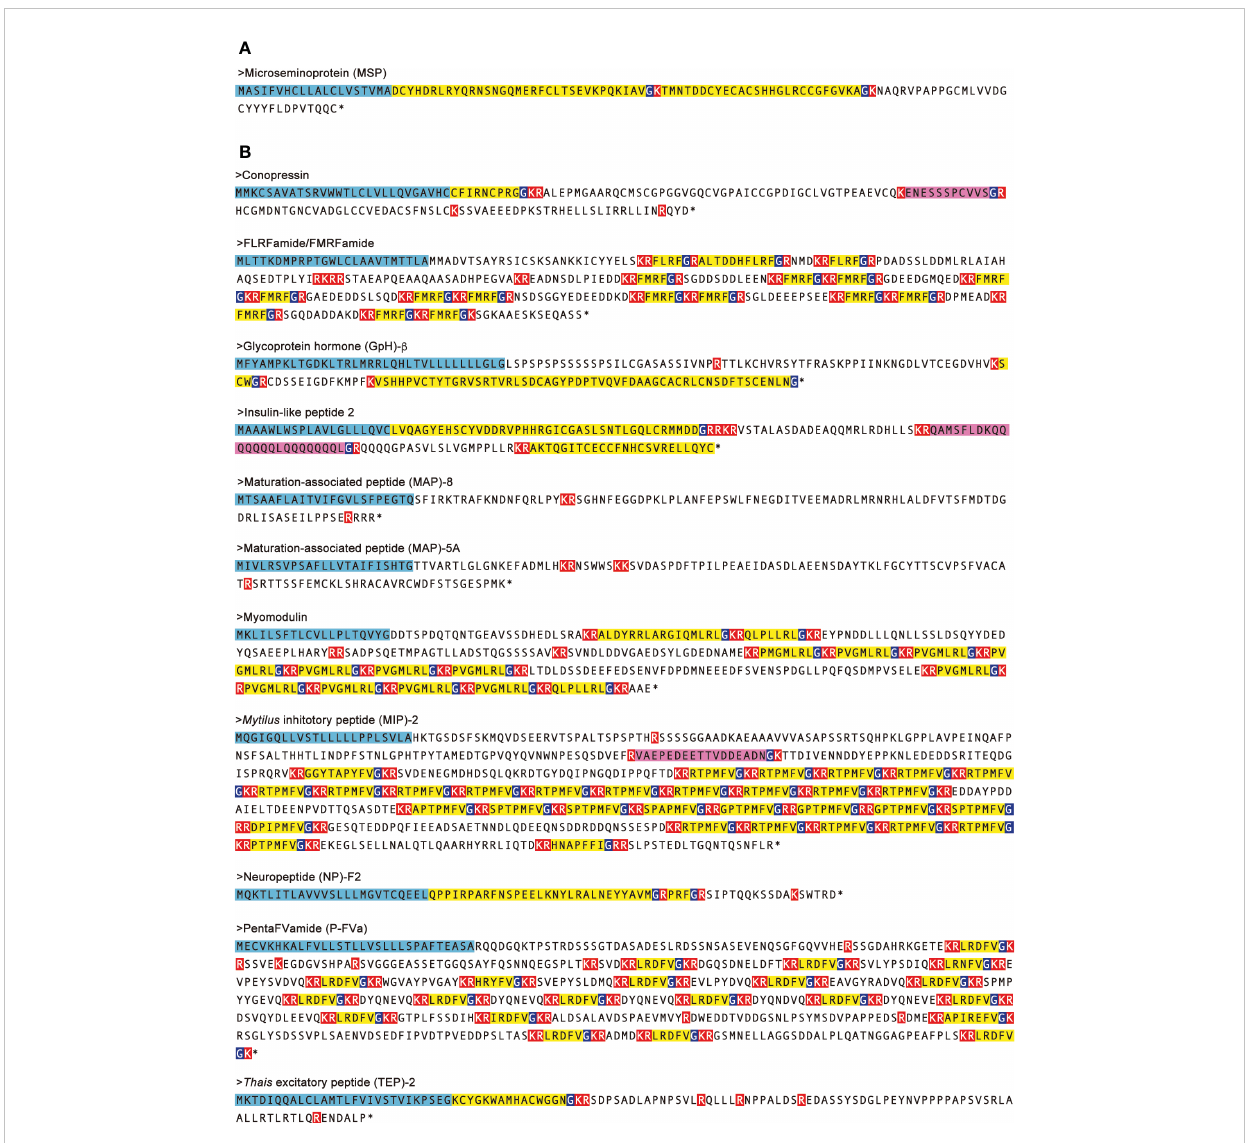
FIGURE 5 Amino-acid sequences of neuropeptide precursors which are up- and down-regulated in both male and female CSM snails. Neuropeptide precursors up- (A) and down- (B) regulated in both of male and female CSM snails were indicated. Amino-acid sequences of the precursors were predicted by translating nucleotide sequences of transcript models assembled using RNA-Seq data. N-terminal signal peptides are highlighted with light blue. Predicted processing sites and Gly residues for amide-donner are highlighted with red and dark blue, respectively. Predicted mature peptides are highlighted with yellow. Unique peptides in the precursor are highlighted with magenta. Asterisks represent that amino acid sequence was terminated by stop